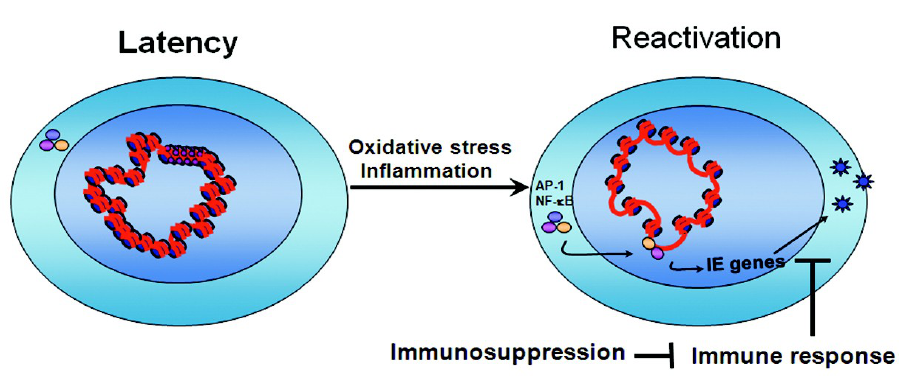
Figure 3. Model for reactivation of CMV from latency. In latently infected cells, episomal viral genomes are heterochromatinized, and transcription factors that drive IE gene expression, such as NF-  B and AP-1, are inactive (NF-  B depicted as cytoplasmic trimeric complex of p65, p50, and the inhibitory subunit, I  B). We propose that inflammatory cytokines and oxidative stress lead to activation of transcription factors that bind to the MIEP and induce chromatin remodeling to activate ie gene expression. Reactivation of ie gene expression does not lead to reactivation of virus in immunocompetent individuals, but in immunosuppressed individuals, reactivation of IE gene expression leads to production of infectious